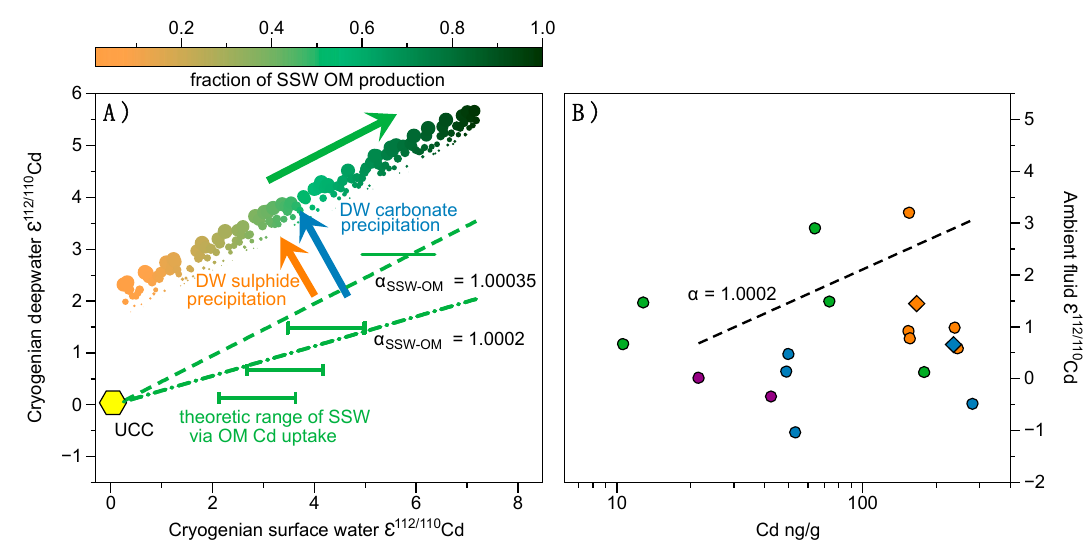
Figure 6. Modelled Cd isotope composition in the Cryogenian surface and deep water ( A ) with measured Cd concentrations relative to its Cd isotopic composition in individual mineral phases ( B ). ( A ) Modelled theoretical Cd isotopic compositions of surface seawater and deep water in a redox stratified restricted marine basin. The colour code from red to green represents increasing Cd uptake in the surface waters by phototrophic biomass. The size of the circles refers to the amount of carbonate over sulphide being precipitated out of deep water in isotopic equilibrium with a DOC pool. The instantaneously formed biomass Cd isotopic compositions are plotted as linear evolving trends (green dashed and dashed / dotted lines) from the initial Cd composition of the UCC [56] for two possible fractionation factors: In the modern Southern Ocean [79] and an average of the whole range of fractionation factors reported in the literature. The analysed OM leachate Cd isotopic compositions are plotted as green dashes representing the horizontal range in theoretical surface water Cd isotope compositions of which Cd was tapped by the OM. ( B ) Cadmium concentrations vs. Cd isotopic composition of the ambient fluid of which Cd was incorporated into authigenic carbonates and sulphides (light shaded symbols). Nonshaded symbols show the obtained Cd concentration and isotopic compositions analysed in the L1 (carbonate) and L4 leachates (sulphide). Error bars = 2 SD (long-term, internal standard reproducibility).